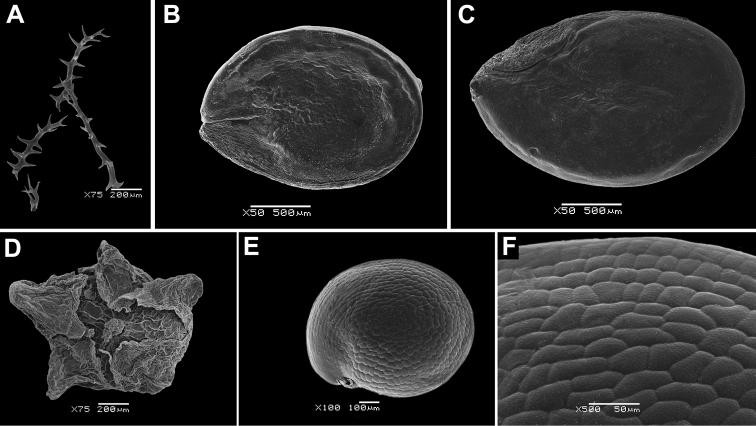
SEM micrographs: AAgriophyllumtibeticum, hairs from the stem BA.tibeticum, concave side of the seed CA.tibeticum, convex side of the seed DSuaedaolufsenii, fruit enclosed in the perianth; E, FS.olufsenii, red seed. Magnification: 50× (A, B), 75× (C, D), 100× (E), 500× (F).